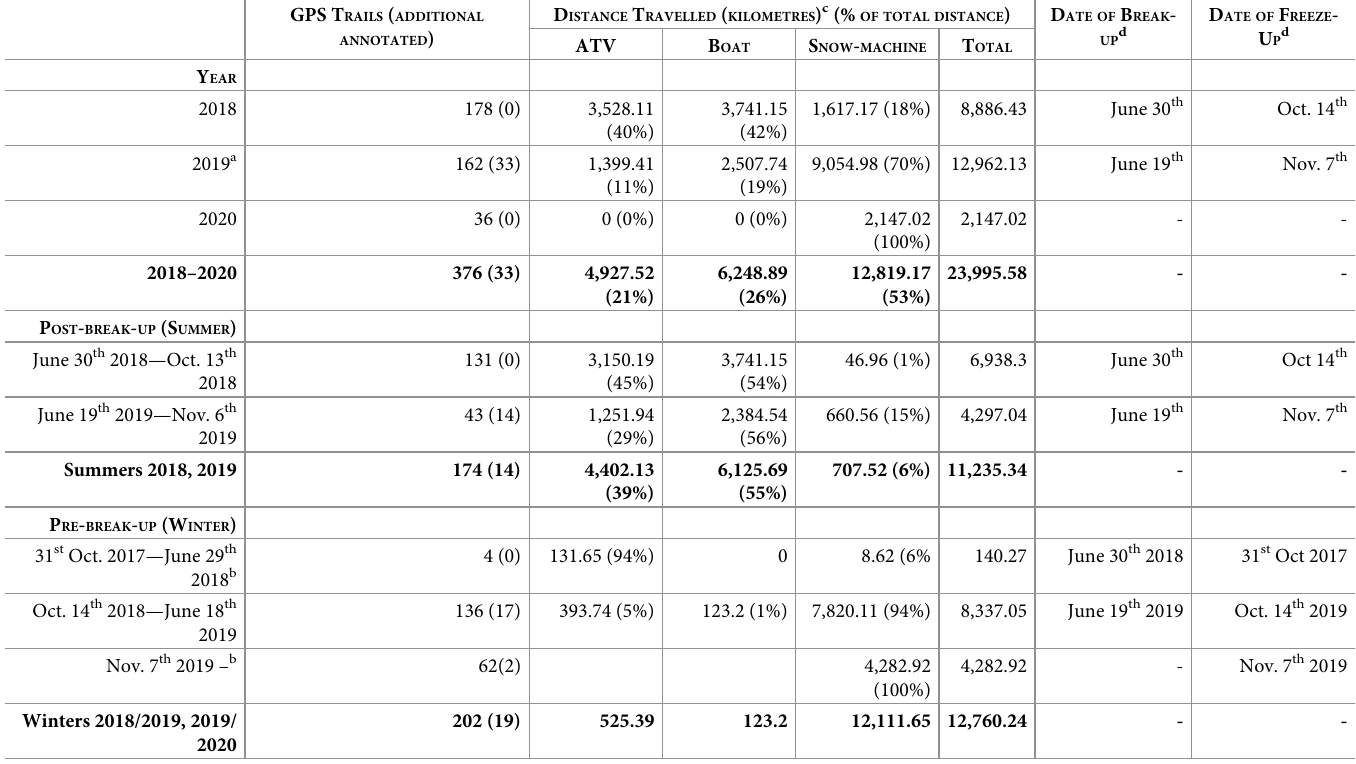
Table 2. Distances travelled by year, mode of transport as part of the Tooniktoyok project, June 2018-June 2020. GPS T RAILS ( ADDITIONAL ANNOTATED